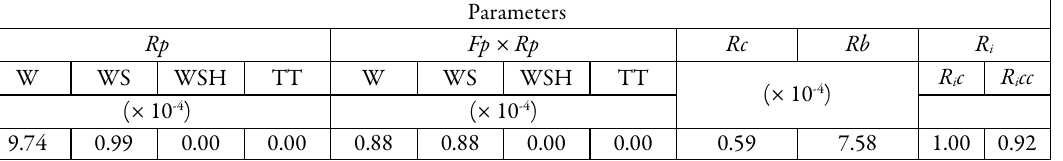
Table 4. Quantitative outputs of the residual risk of illness